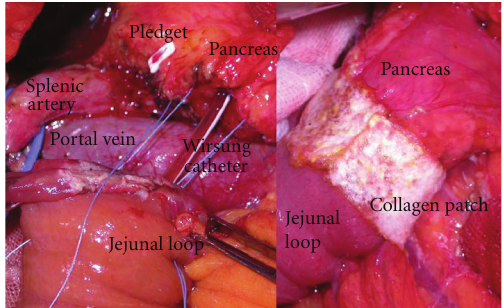
Figure 1: Roux-en-Y pancreaticojejuno anastomosis: pledgetsup- ported Ticron stitches between the seromuscularis of the jejunum and the pancreatic capsule, before the pancreatic invagination. A small catheter is inserted in the main pancreatic duct. On the right side, anterior aspect of pancreaticojejunal anastomosis after application of